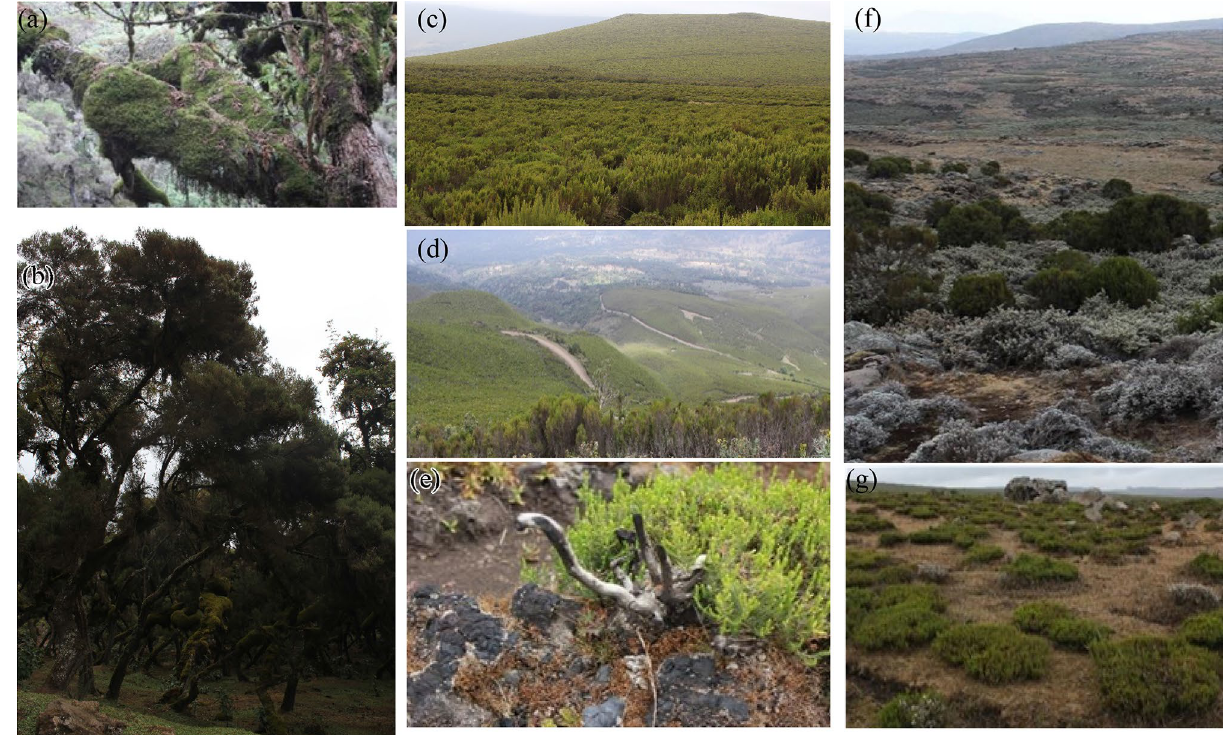
Figure 2. Erica succession and distribution patterns along the Bale Mountains. ( a , b ) Old Erica tree stand up to 12 m high with thick Breutelia spp. Moss on the stem, ( c , d ) Ericaceous Belt: young Erica brush 1–5 years old (1–3 m high), ( e ) Erica lignotubers regeneration after a fire event, and ( f , g ) Isolated Erica groves at the Erica a froalpine grassland ecotone mainly dominated by isolated Erica shrubs and different